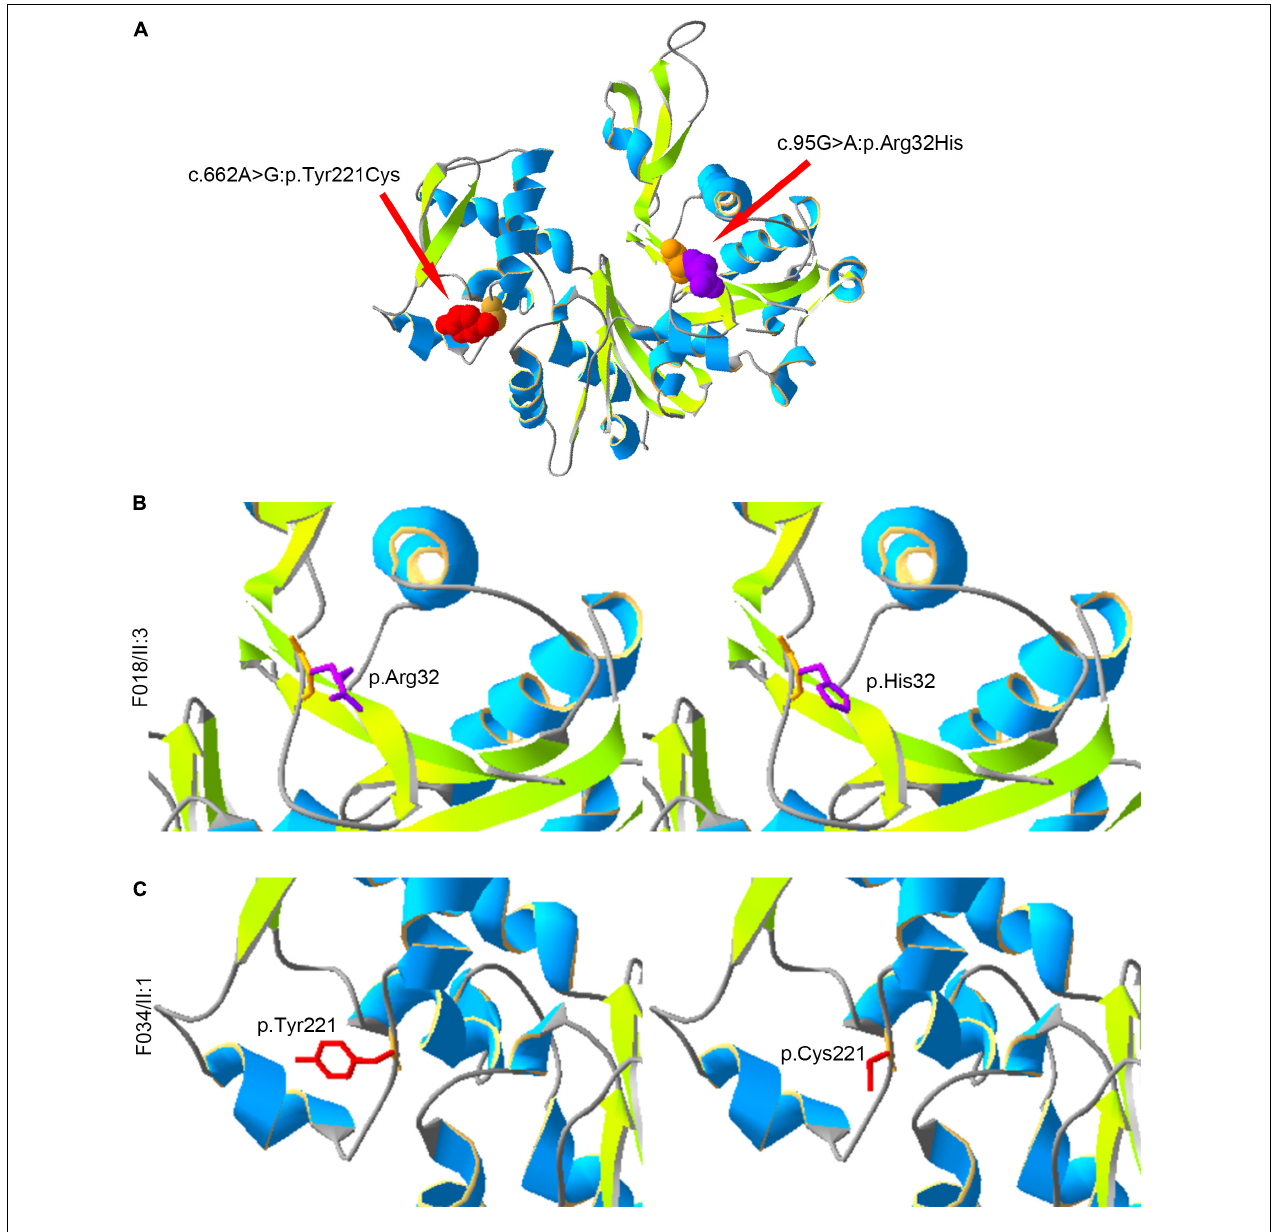
FIGURE 2 | Locations of the amino acids affected by pathogenic variants in the three-dimensional structure of ACTRT1. (A) The positions of the amino acid substitutions in the three-dimensional structure of the original ACTR1 protein. (B) The pathogenic variant c.95G > A:p.Arg32His effect on the three-dimensional structure of ACTRT1. (C) The pathogenic variant c.662A > G:p.Tyr221Cys effect on the three-dimensional structure of